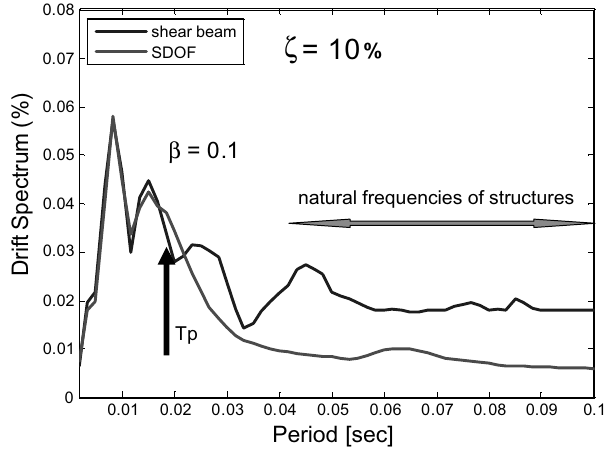
Fig. 3. Drift Spectrum for the SDOF and the uniform shear-beam models. The associated waveforms are displayed on the right side of Fig. 2. SDOF drift spectra significantly underestimate maximum deformation for the period range larger than T p .